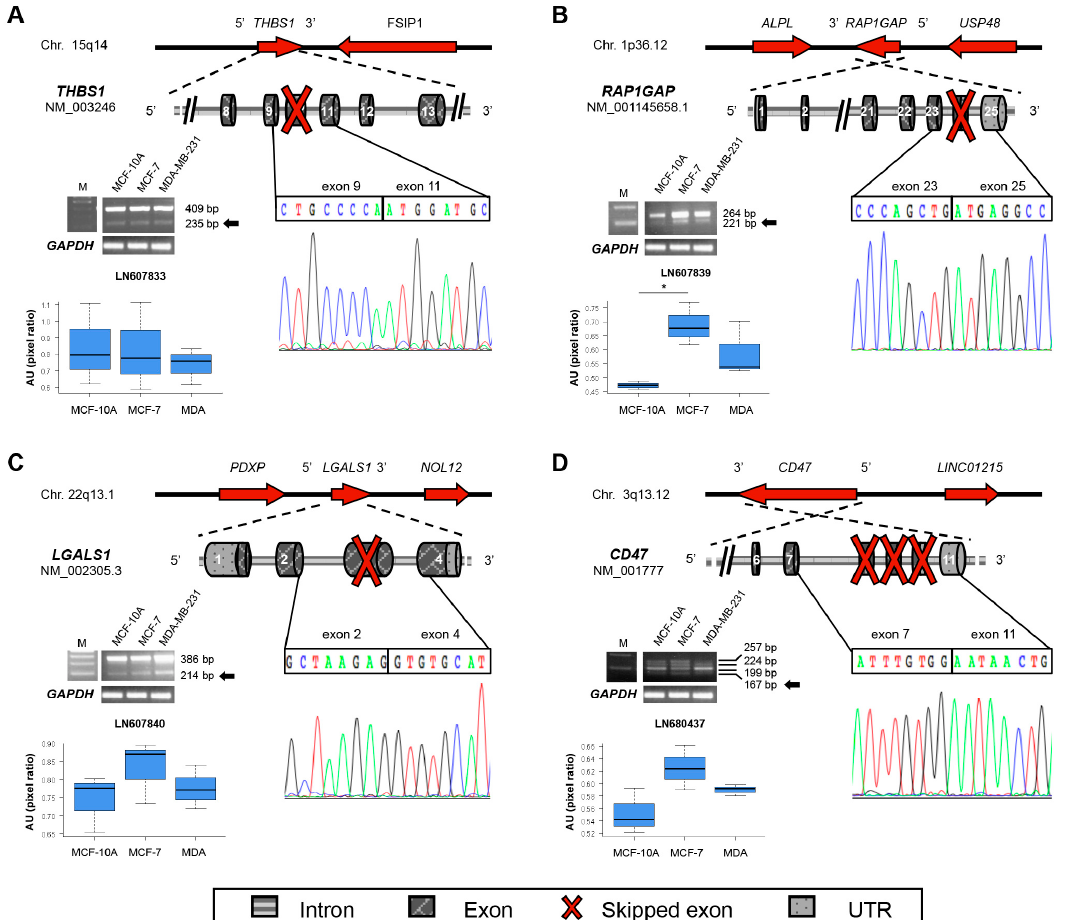
Figure 2. Schematic representation of de novo identified transcripts for adhesion-related genes and their differential expression by RT-PCR in breast cell lines (a representative image is shown for each gene). ( A ) THBS1 new transcript; ( B ) RAP1GAP new transcript; ( C ) LGALS1 new transcript; ( D ) CD47 new transcript. For each new transcript, in the upper part is shown the genomic region encompassing the gene; red arrows indicate the direction of transcription. Below, the exon/intron structure of the gene is depicted. Red cross indicates the exons that are spliced out in the new transcript. The electropherogram and the nucleotide sequence above refer to the new splice junction identified. Images of PCR amplicons on agarose gel from three independent replicates experiments were acquired. For all panels, M is 100 bp DNA marker. The black arrows indicate the PCR band corresponding to the newly identified transcripts. Pixel density of each band (only for the newly identified mRNA isoforms) was quantified by ImageJ software and compared to the pixel density of the 100 bp DNA marker (at known concentration) to normalize data across replicates and cell lines. GAPDH gel bands are reported below to show that the starting amount of template was the same for all analyzed samples. Values are reported as AU = Arbitrary Units in the boxplots. Dark horizontal lines represent the mean, the box represents the 25th and 75th percentiles and the whiskers the 5th and 95th percentiles. Asterisks indicate significant p values (* p < 0.05).